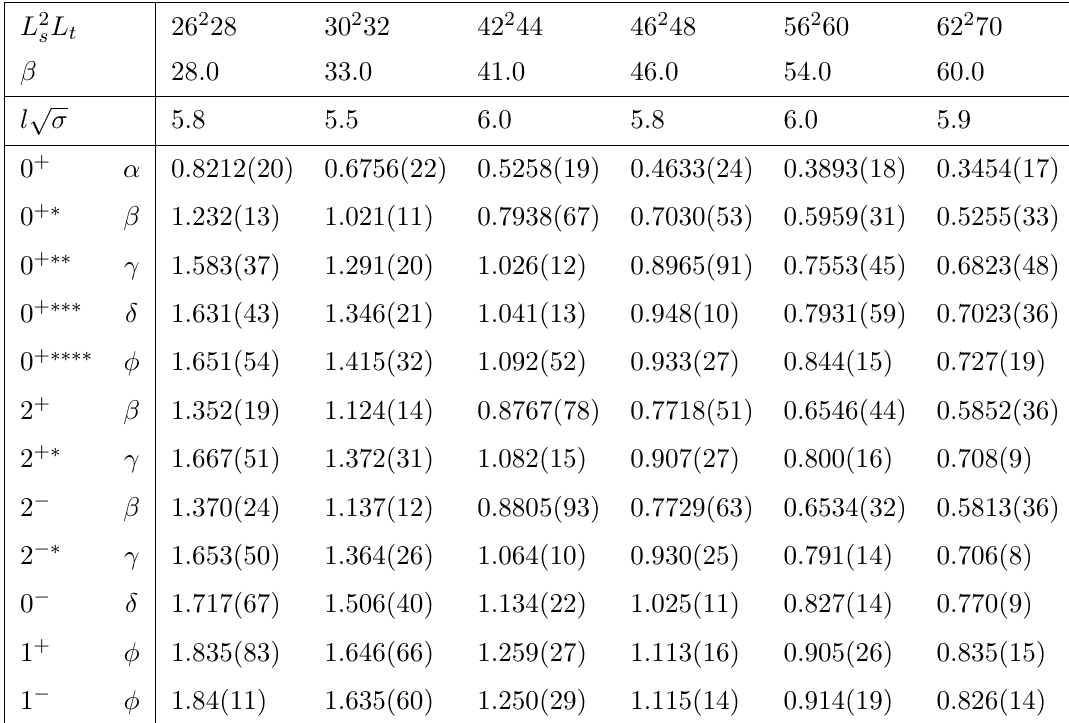
Table 23 . SO(6) glueball masses am G . Grades, e.g. (cid:11) , explained in section